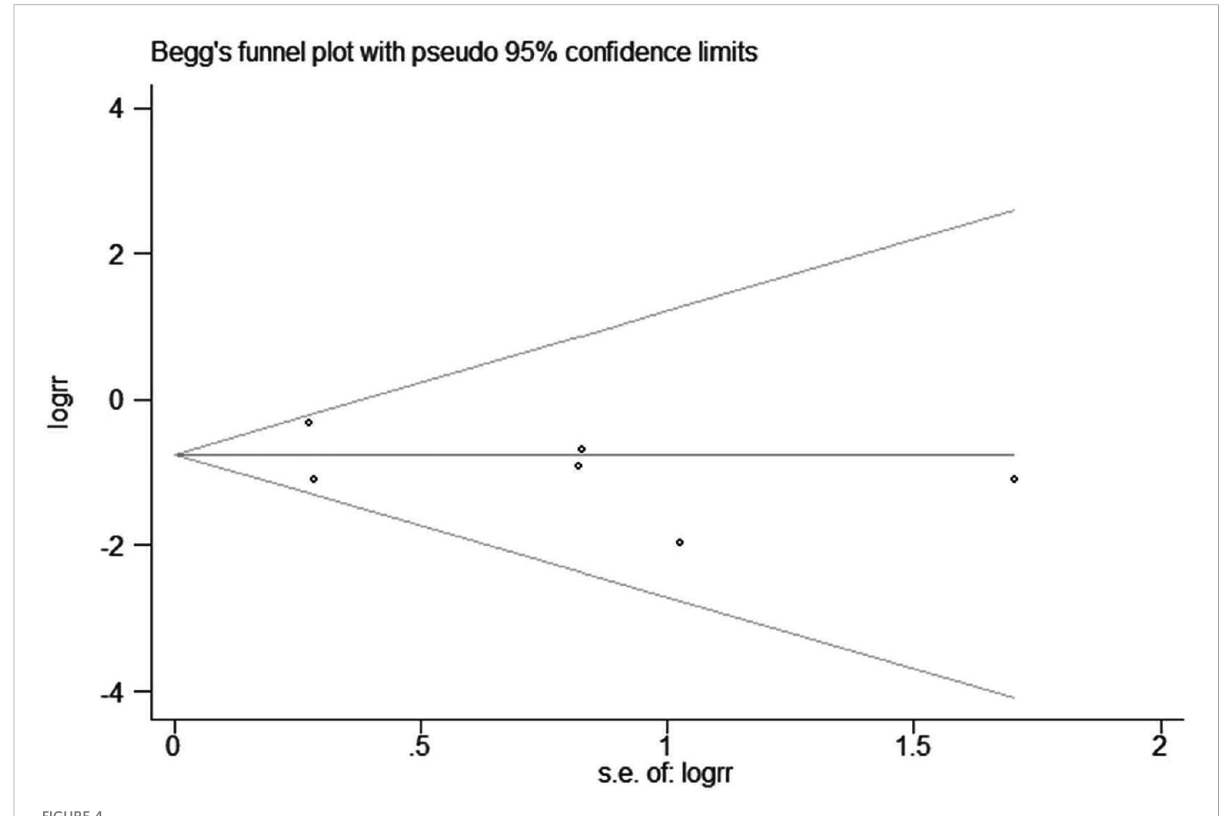
FIGURE 4 Begg ’ s funnel plot for the incidence of postoperative